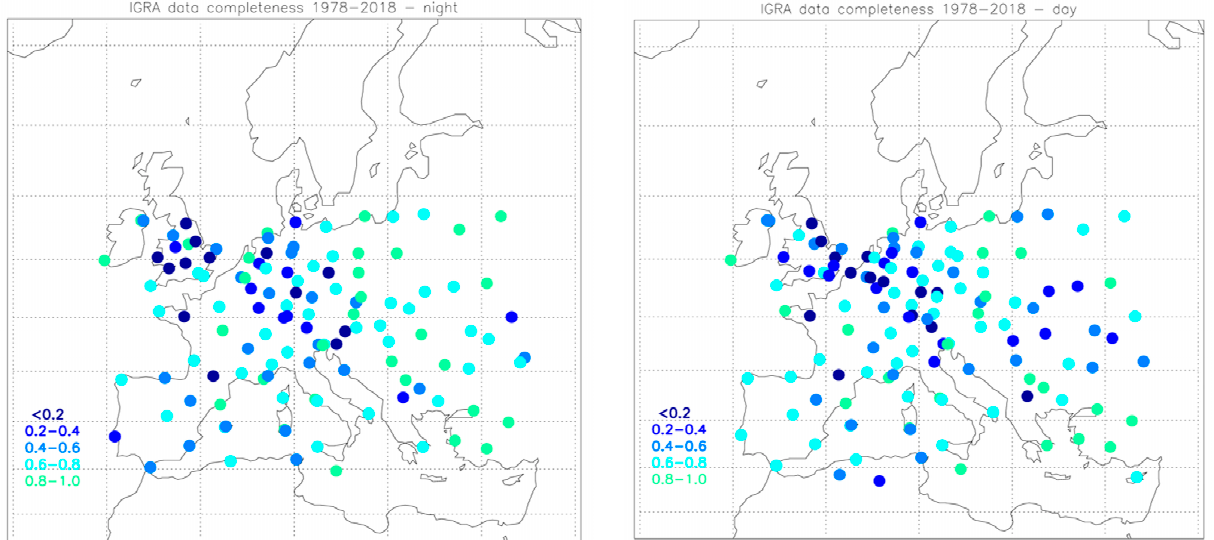
Figure 1. Map of the radiosoundings stations considered in the study. Colors represent the degree of completeness for the nighttime ( left panel) and daytime ( right panel) time series available from the European mid-latitude stations. Data completeness is calculated as the fraction of the night and day measurements available since 1 January 1978.